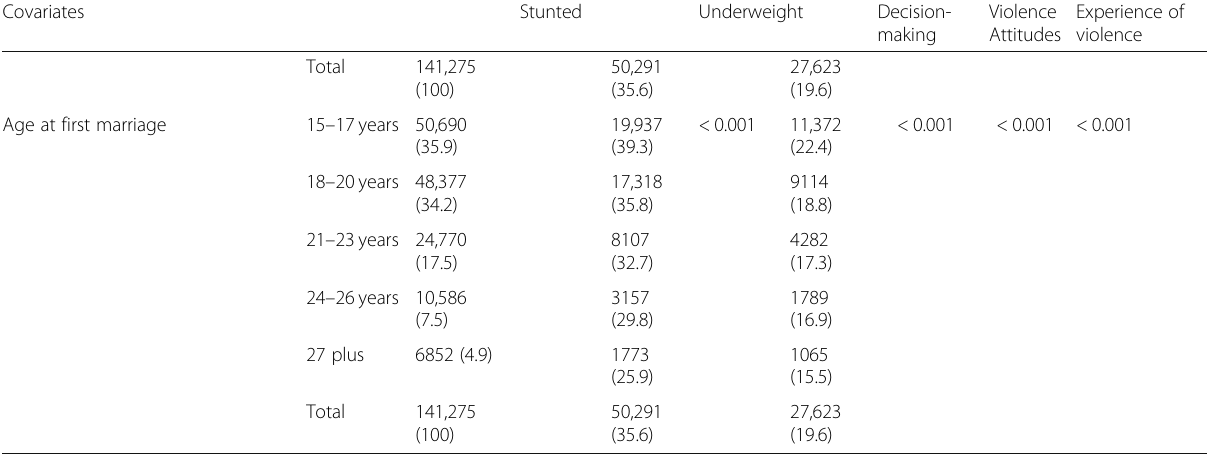
Table 3 Relationship between outcomes and Exposures with Covariates (Continued) Covariates Stunted Underweight Decision-